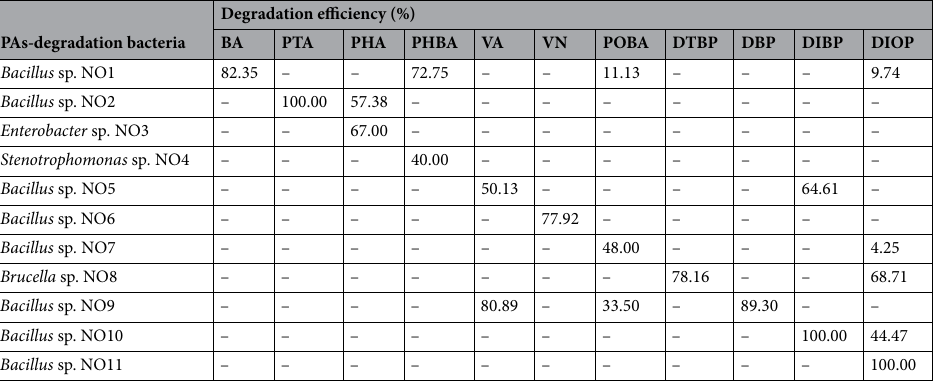
Table 3. PAs-degrading bacteria and their degradation efficiencies in mineral salt medium (MSM). *“–”, no PA-degrading potential.